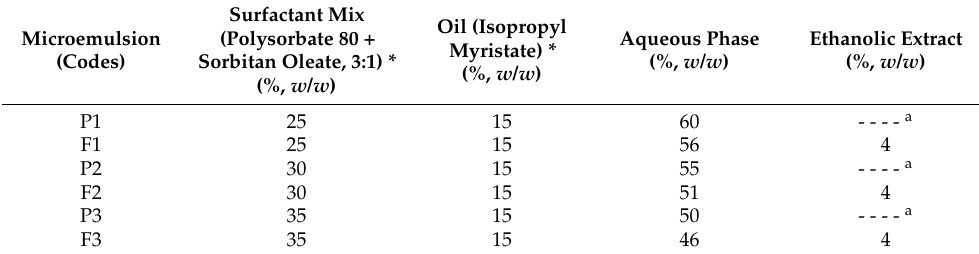
Table 1. Composition of placebo and active